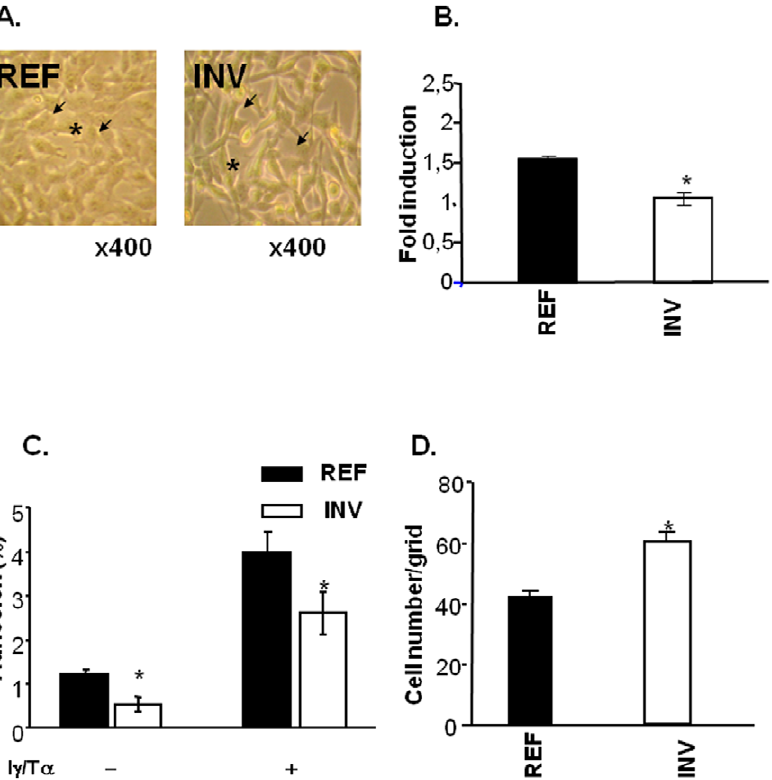
Figure 2. REF and INV cell adhesion and transmigration. Morphology of INV and REF cells (A) revealed by optical microscopy at 6 400 magnification. Arrows indicate cell junctions and asterisks indicate cell shape. Adhesion to fibronectin (B) and hCMEC/D3 endothelial cell adhesion assay (C). Transmigration assays (D) involved growing hCMEC/D3 endothelial cells to confluence on the upper side of 8 m m insert Boyden chambers. CMFDA-stained cells that transmigrated through the endothelial cells were counted as described in ‘‘Materials and Methods’’. For adhesion to fibronectin, the data were normalized to BSA adhesion. Each column shows means ( 6 SD) of three independent experiments. * P , 0.05.